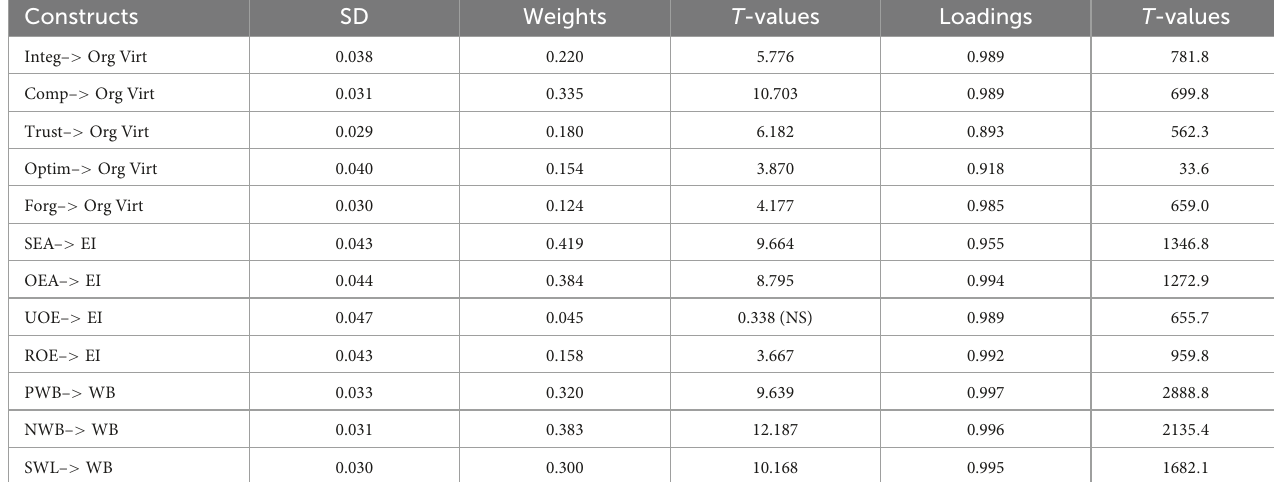
TABLE 4 Second-order measurement model.